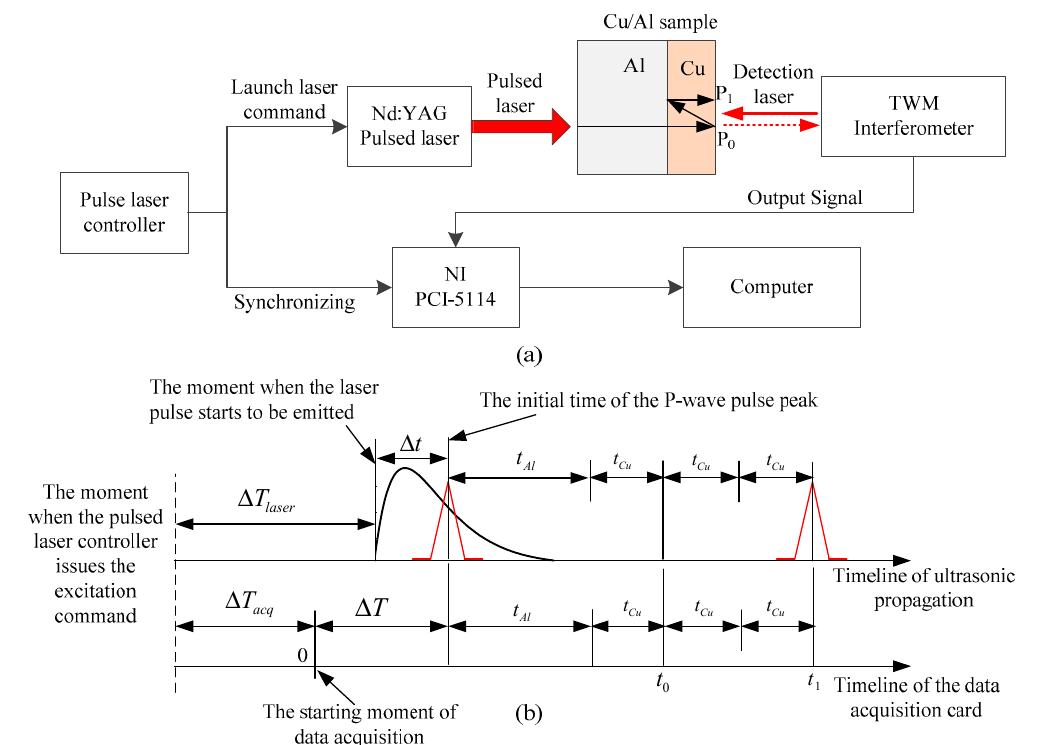
Figure 3. Experimental platform: ( a ) the schematic diagram of measurement system; ( b ) the system delay sequence diagram.